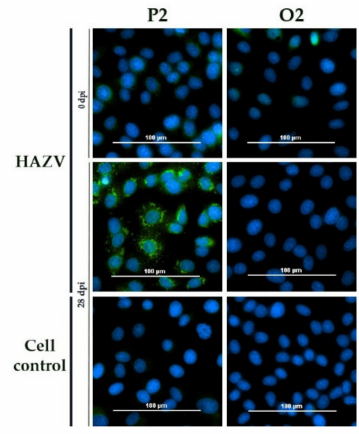
Figure 1. HAZV iIFA: The post infection serum of sheep P2 led to a specific staining of HAZV-infected Vero E6, whereas the (NSDV) mock control O2 did not test positive. Sera prior to infection as well as post infection sera tested on non-infected Vero E6 cells, did not reveal a specific